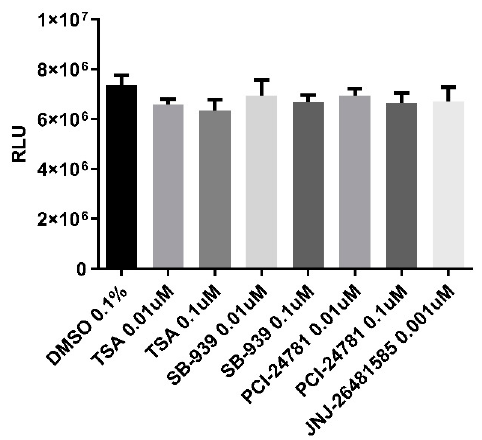
Figure 6. CellTiter-Glo assay showing the effect of test compounds on human neural progenitor cells viability after 24 hours of exposure. There was no significant toxicity upon treatments. Data are mean of the experiment results performed in quadruplicate. Error bars represent SD.